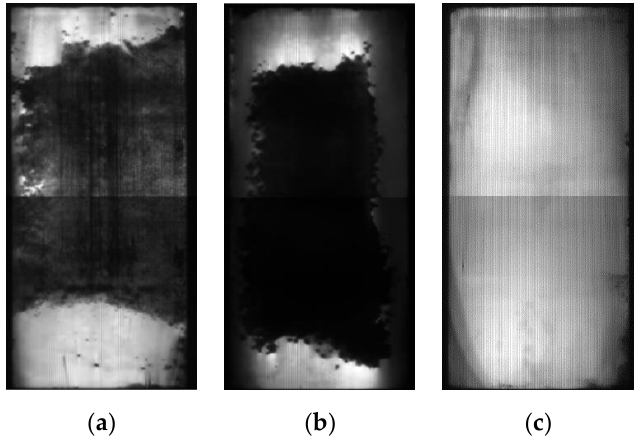
Figure 10. Electroluminescence images of the PV modules after the recovery test: ( a ) back contact, ( b ) front contact, and ( c ) frame contact.